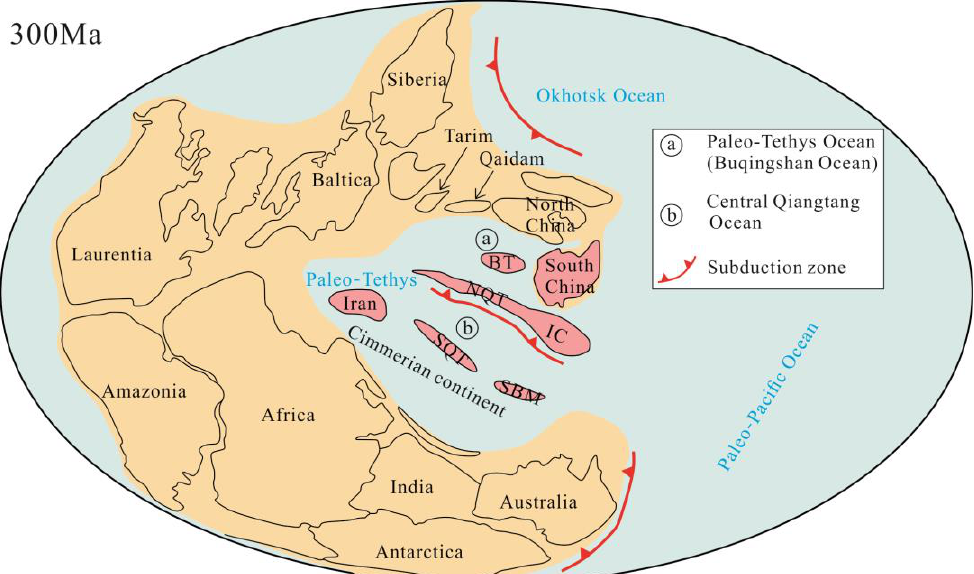
Figure 11. Reconstruction of East Asian blocks showing the spreading of Northern Paleo-Tethys Ocean (Buqingshan Ocean) (modified from [10,17,78 – 82]. SQT — South Qiangtang Terrane; NQT — North Qiangtang Terrane; BT — Bayan Har terrane; SBM — Sibumasu Terrane; IC — Indochina Terrane.